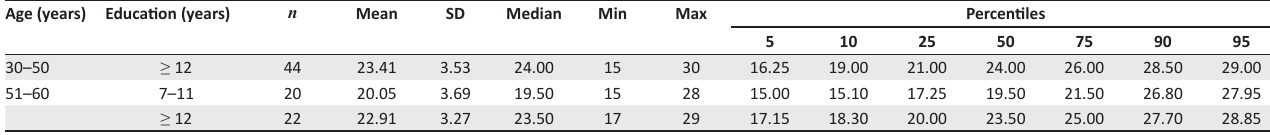
TABLE 3: Descriptive statistics for total Montreal Cognitive Assessment scores stratified by age and years of education. Age (years) Education (years)